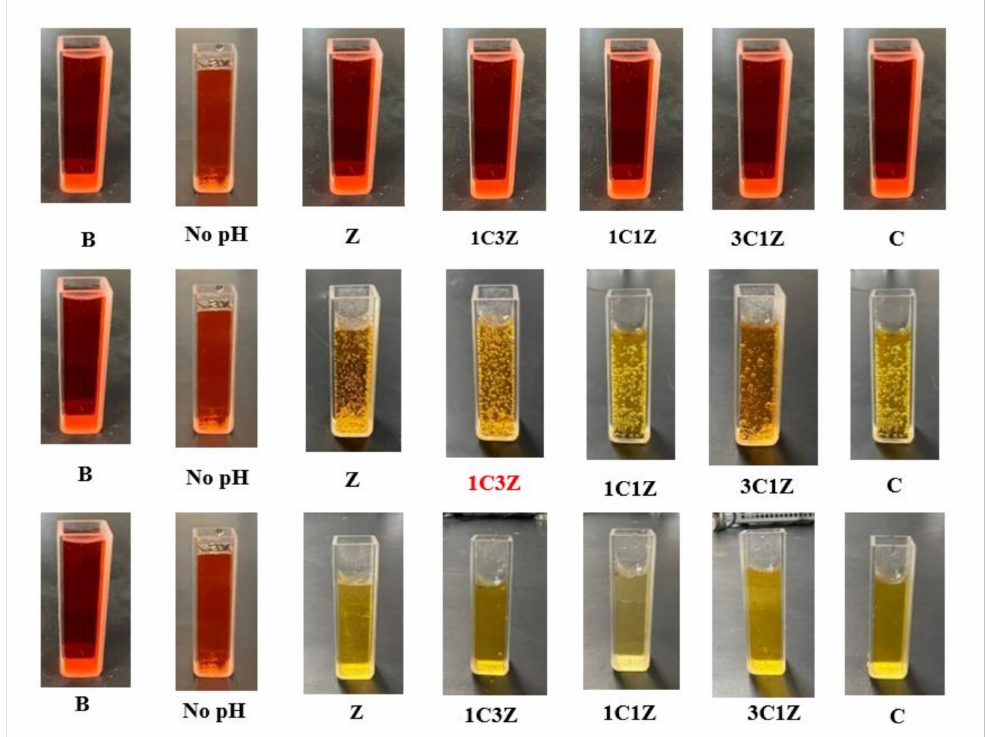
Figure 10. The color and the appearance of the MO solution before adding a catalyst (first row), after 3 h (second row), and 24 h (third row) of adding the